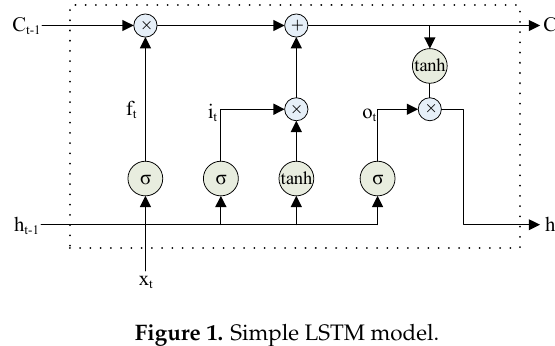
Figure 1. Simple LSTM model.